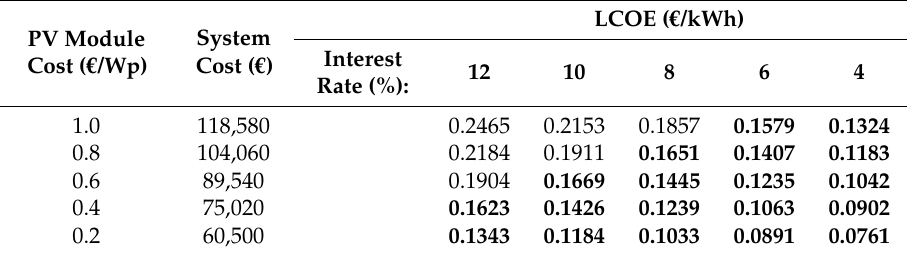
Table 9. LCOE over a range of interest rates (50,000 W inverter, deterministic method).